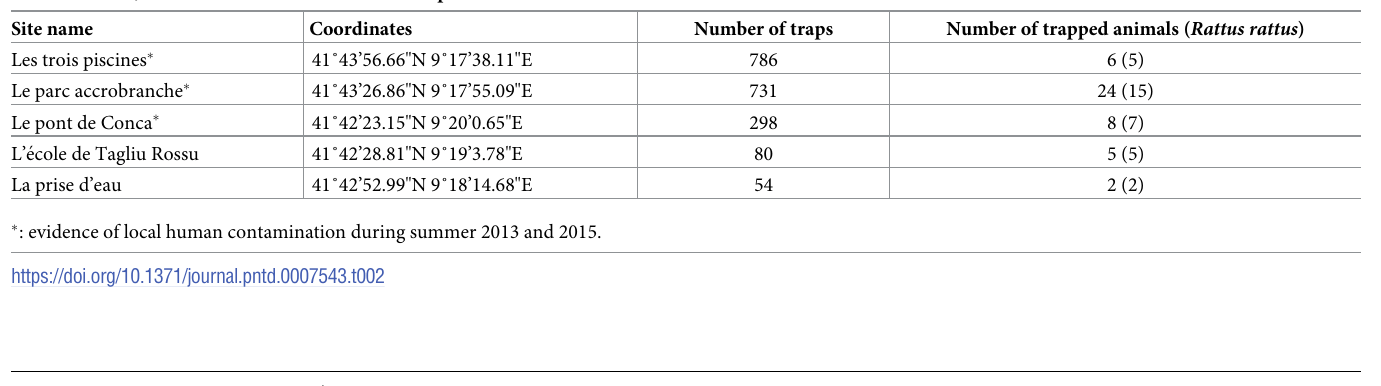
Fig 2. Occurrence of the ELISA index (EI) values given by the analyzed sera samples in goats, cows and sheep.